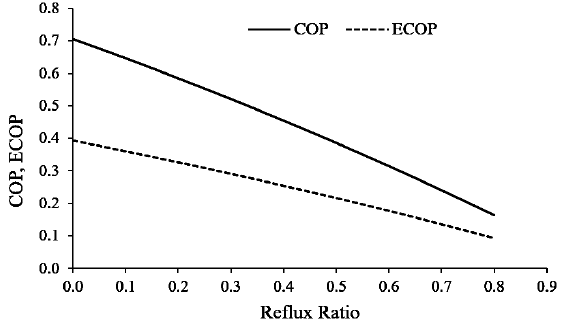
Figure 15. Effect of reflux ratio on COP and ECOP.